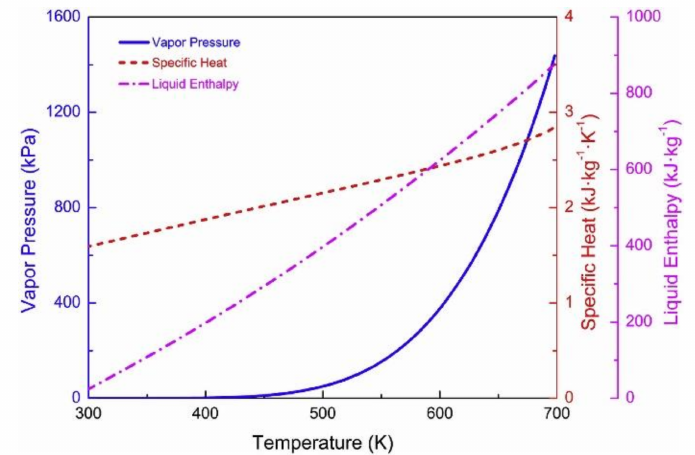
Figure 2. Thermodynamic properties of DOWTHERM A heat transfer